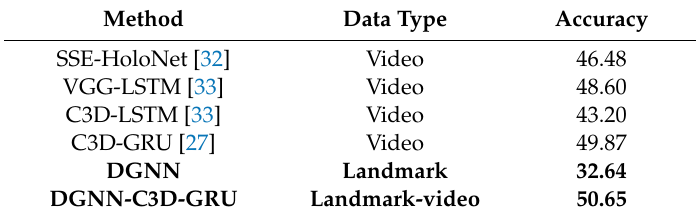
Table 4. Experimental results for the AFEW dataset. The proposed methods are highlighted in bold.